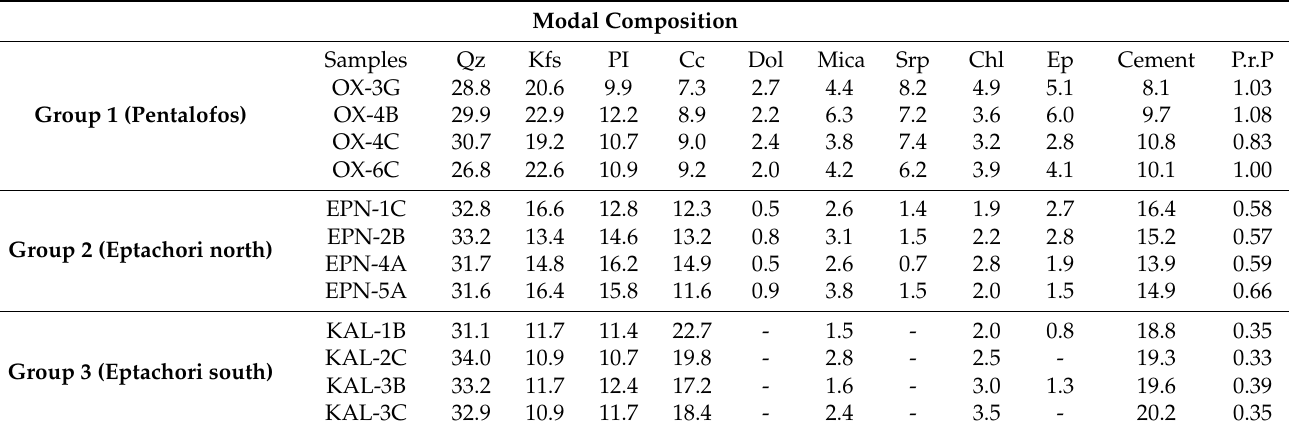
Table 7. Quantification of modal composition of the representative investigated groups of